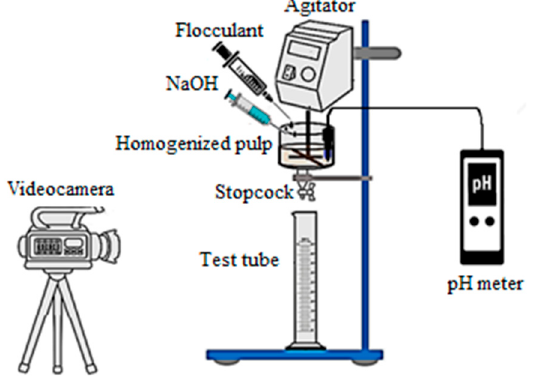
Figure 1. Experimental apparatus.